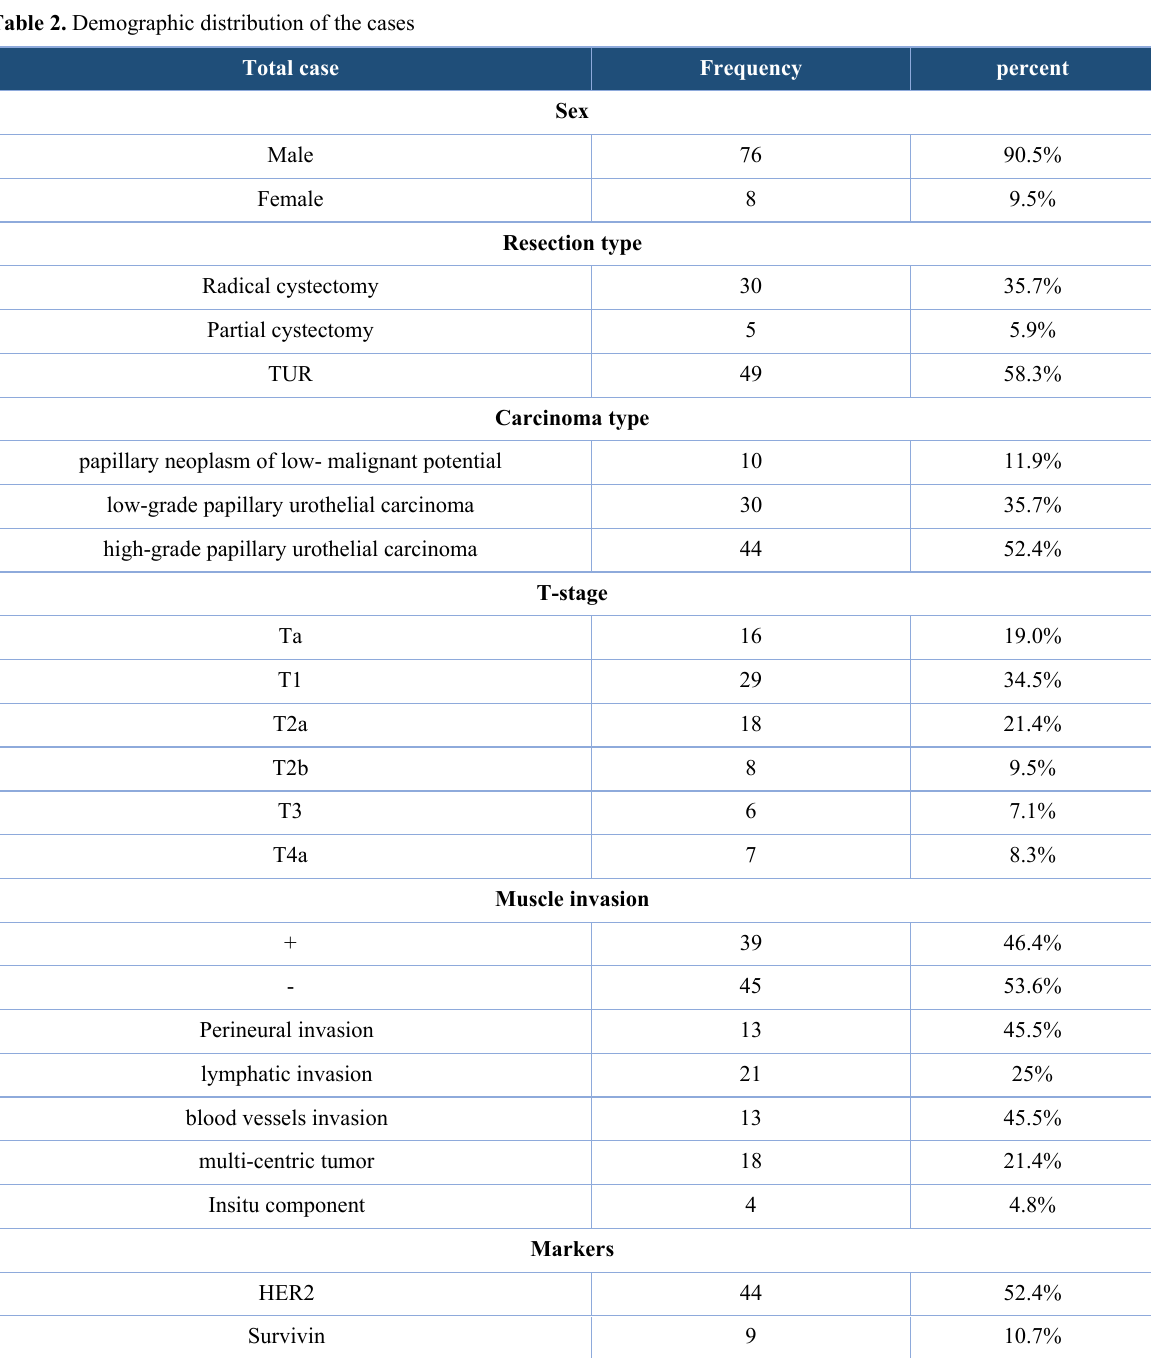
Table 2. Demographic distribution of the